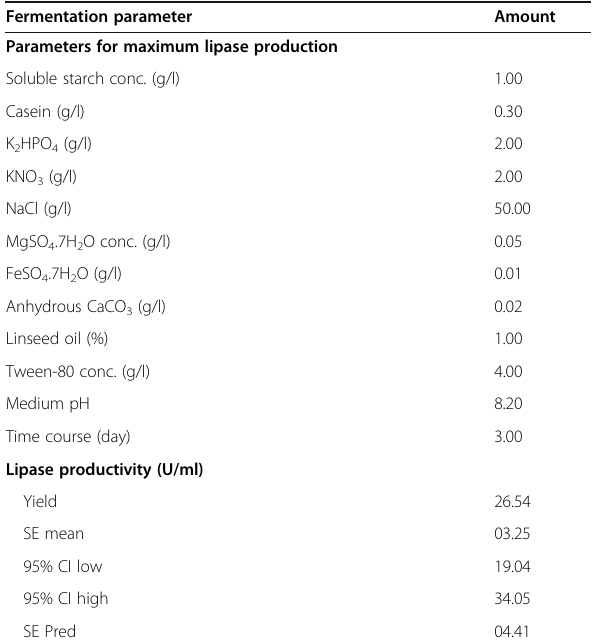
Table 6 The optimum parameters and lipase productivity defined by the Box-Behnken design and